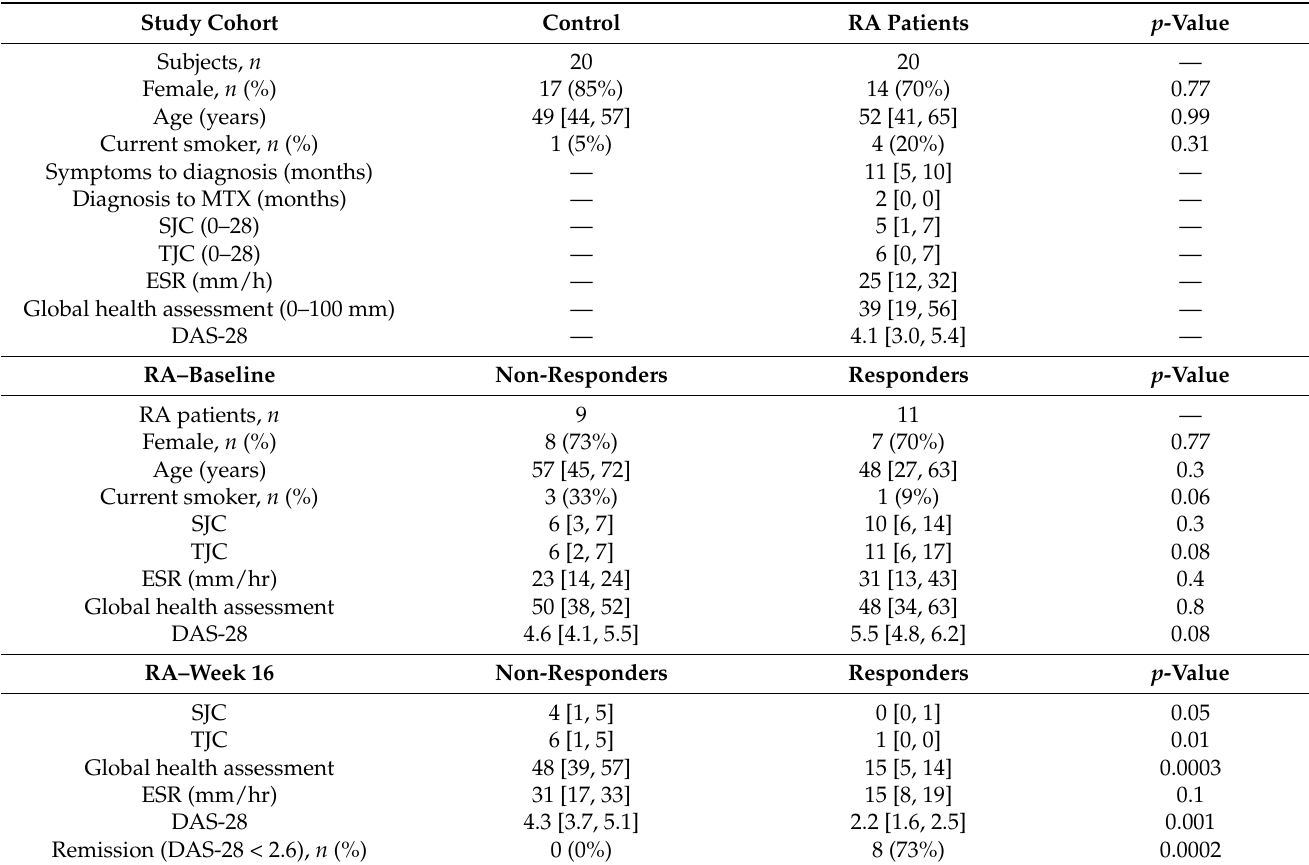
Table 1. Demographic data for study population. RA patients were characterized as “responders” and “non-responders” based on a reduction in DAS-28 of greater than 1.2 ( δ DAS-28 (< − 1.2)). Data are presented as median [IQR] unless otherwise noted. Swollen joint count (SJC); tender joint count (TJC); erythrocyte sedimentation rate (ESR); disease activity score